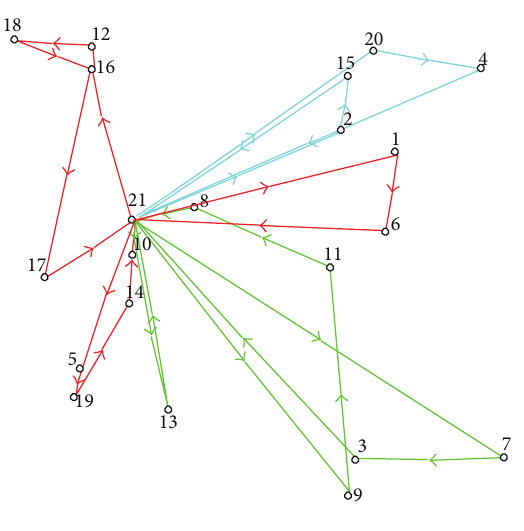
Figure 7: Optimal